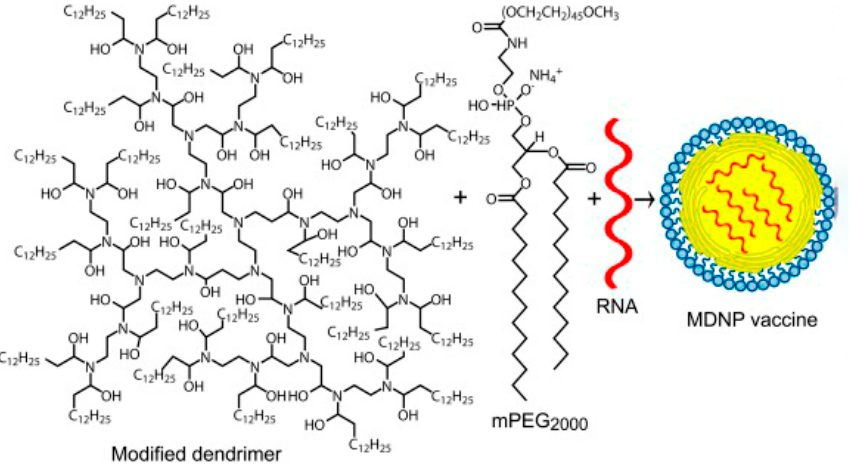
Figure 7. The structure of the amphiphilic dendrimer used for preparing MDNP [142]. MDNP-encapsulated RNAs have been successfully expressed in a wide range of cell culture types, including the HeLa human epithelial cell line, mouse and human primary fibroblasts, a mouse dendritic cell line, etc.